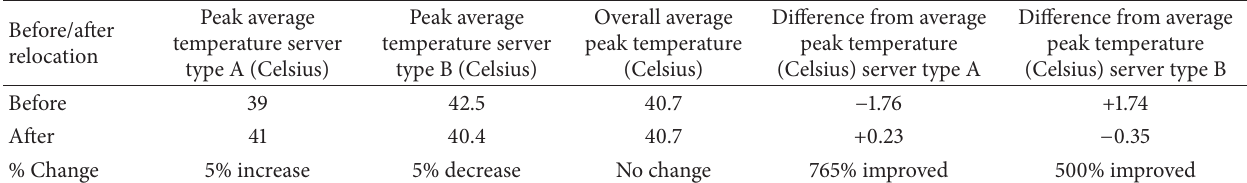
Table 5: Average outlet temperatures of relocated servers before and after relocation.